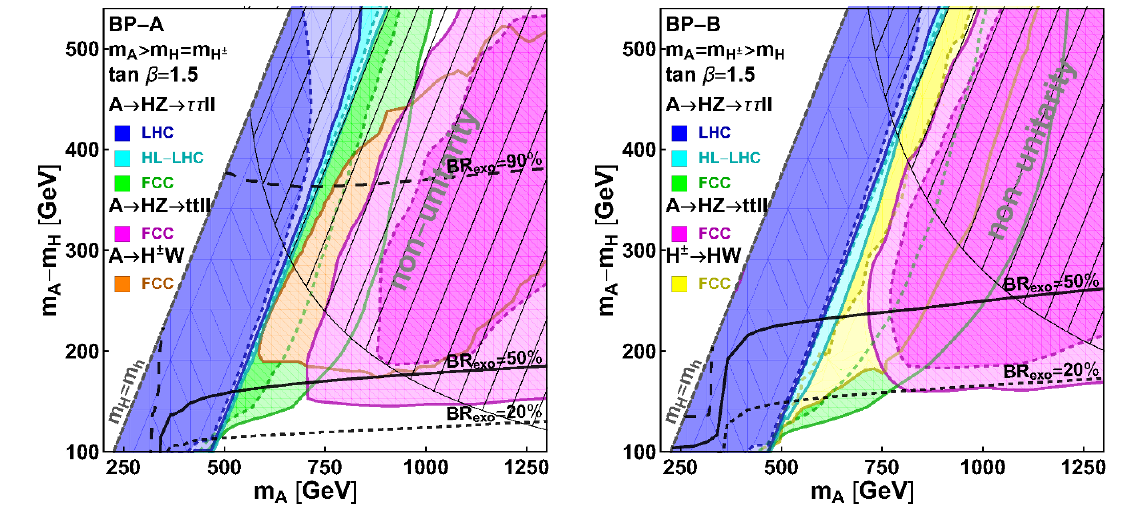
Figure 7 . Reach for the exotic Higgs decay channels at the LHC, HL-LHC and 100 pp TeV collider for BP-A (left) with the mass hierarchy m H = m < m A and BP-B (right) with the mass H (cid:6) hierarchy m H < m = m A . The results are presented in the m A vs. m A (cid:0) m H plane for a (cid:12)xed H (cid:6) value of t (cid:12) = 1 : 5. We show the projected sensitivity of the A ! (cid:28)(cid:28)‘‘ channel (blue/cyan/green) as discussed in section 3.2.2, the A ! tt‘‘ channel (magenta) as discussed in section 3.2.3, the A ! H (cid:6) W (cid:7) (orange) as discussed in section 4.2 and the H (cid:6) ! HW (cid:6) channel (yellow) as discussed in section 5.2. The exclusion and discovery reaches for each channel are shown as solid and dashed lines respectively. The hatched regions are excluded by unitarity constraints and the thick black lines indicate the branching fraction for exotic Higgs decays of the heavy pseudoscalar A .